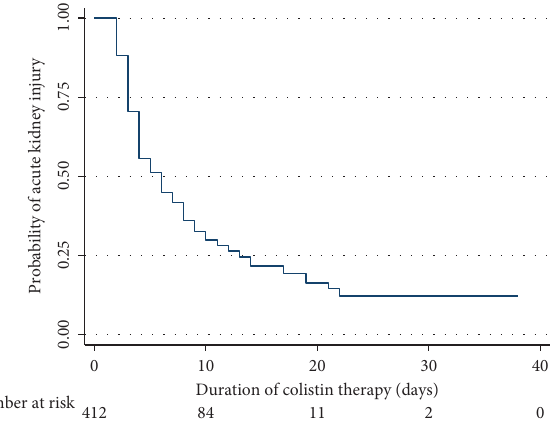
Figure 1: Kaplan–Meier curve demonstrates the probability of AKI occurrence during colistin treatment over time. Table 2: Univariate and multivariate analyses to identify the factors associated with colistin-induced AKI.